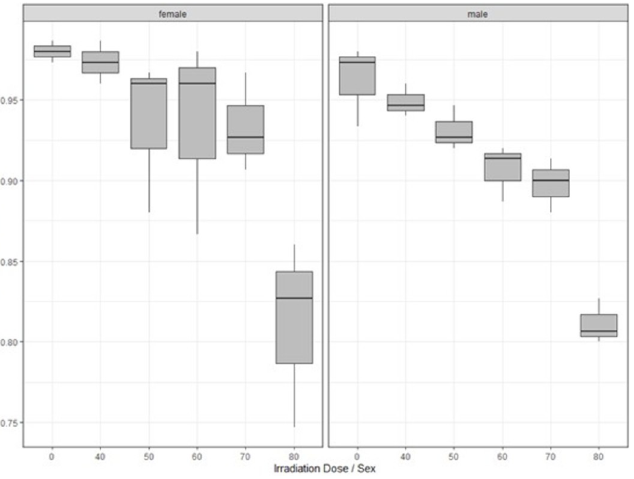
Fig 1. Percentage of pupal survival up to adult stage of male and female Ae . aegypti following exposure to different irradiation doses. Each box denotes the median as a line across the middle, the quartiles (25 th and 75 th percentiles), the minimum and maximum values at the ends of the vertical lines. Results are expressed as mean ± SE.